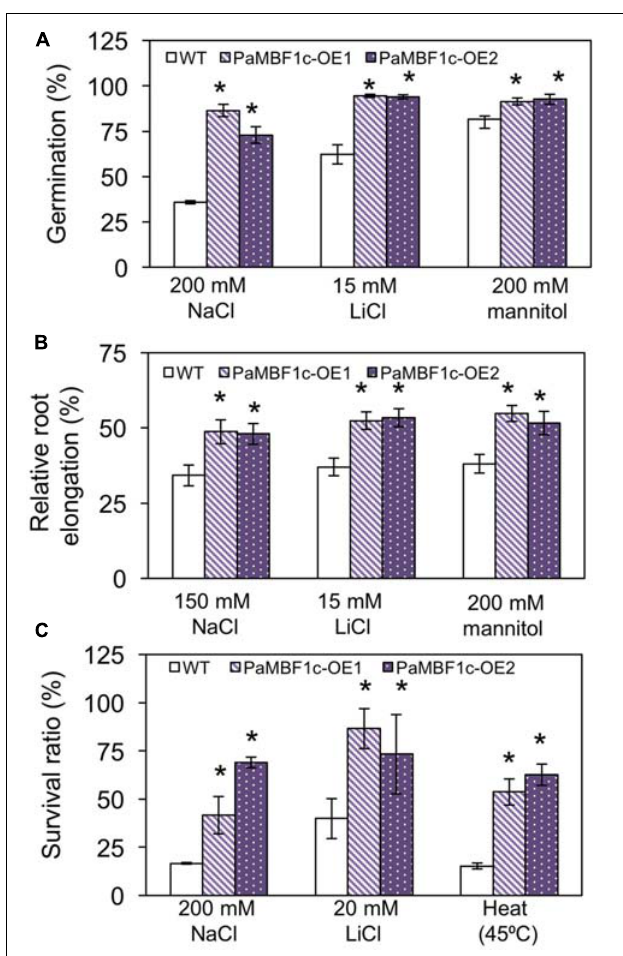
FIGURE 4 | Evaluation of PaMBF1c -OE lines under different abiotic stress conditions. (A) PaMBF1c -OE lines germinated better than did WT under salt stress (200 mM NaCl), ionic stress (15 mM LiCl), and osmotic stress (200 mM mannitol). The number of germinated seeds was expressed as a percentage of total number of seeds planted ( n ≥ 100). Radicle emergence was considered germination and the germination was scored after 4 days of planting. (B) Roots of PaMBF1c -OE lines elongated longer than that of WT under salt stress (150 mM NaCl), ionic stress (15 mM LiCl), and osmotic stress (200 mM mannitol). Root growth was scored after 6 days of transfer of seedlings from normal medium to stress medium. Root elongation of seedlings under stress conditions was expressed as a percentage of each stress control grown on normal MS medium after 6 days of transfer ( n ≥ 10). (C) PaMBF1c -OE lines survived better than WT under salt stress (200 mM NaCl), ionic stress (20 mM LiCl) and heat stress (45 ◦ C for 60 min) ( n ≥ 15). Error bars represents standard deviation of the mean values of three independent experiments. Asterisks indicate statistical significance in LSD test ( p <